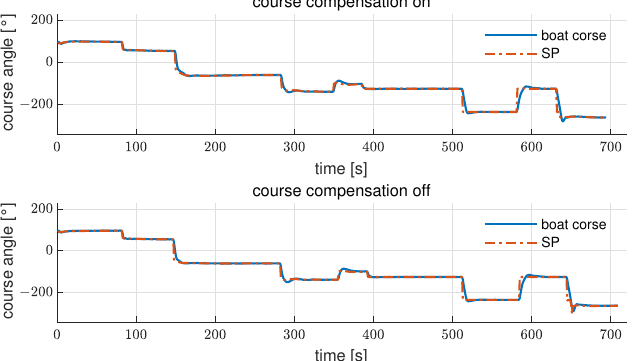
Figure 17. Course change response curve of LOS with and without heading compensation in the current environment. The solid blue line is the actual heading and the dotted orange line SP is the control